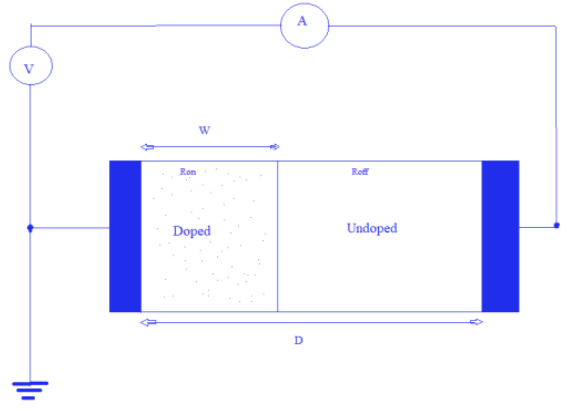
Figure 3. Basic model for Memristor